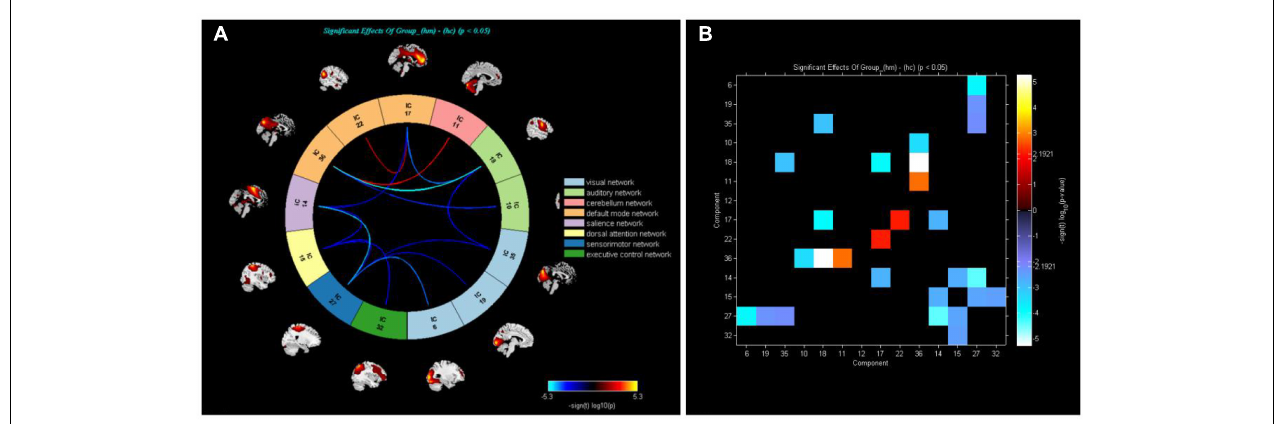
FIGURE 3 | (A) Analysis of whole-brain functional network connectivity intensity allowed calculation of differences between HM and HC groups ( P < 0.05, two-sample t -test). Yellow lines represent better functional connectivity than in HC group, while blue lines represent weaker functional connectivity than in HC group. (B) Group averaged static functional connectivity between independent component pairs was computed using overall resting state data. Values in the correlation matrix represent Fisher’s z-transformed Pearson correlation